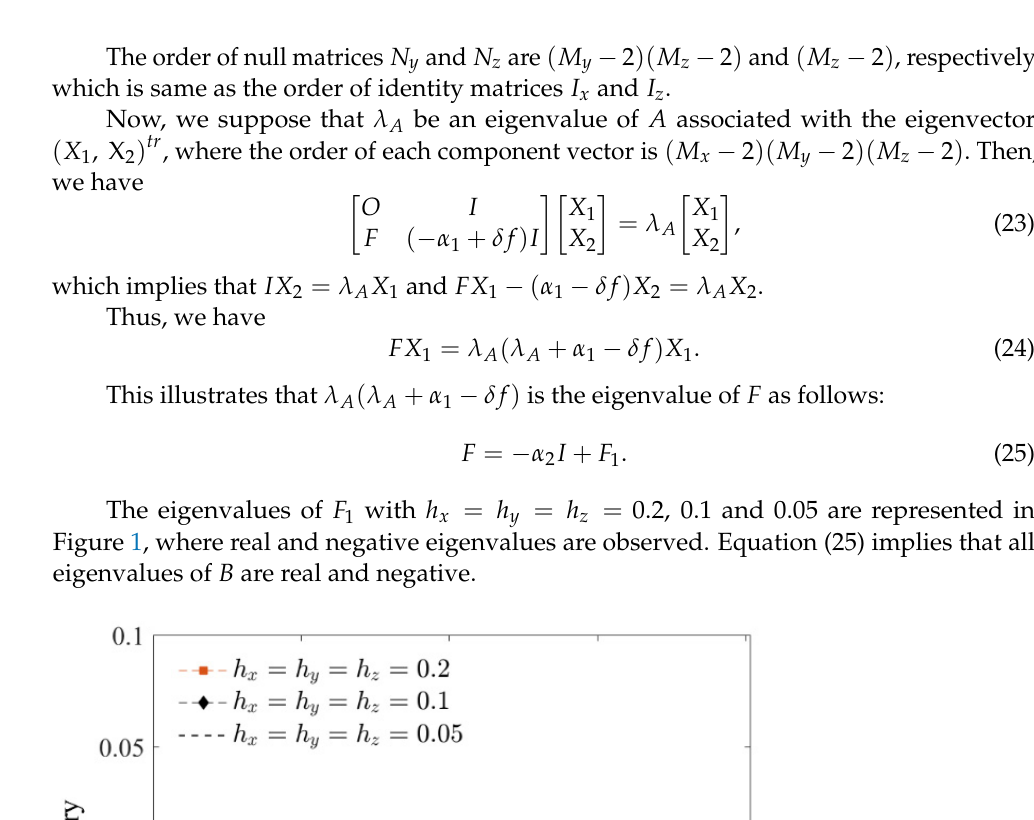
Figure 1. Eigenvalues of the matrix